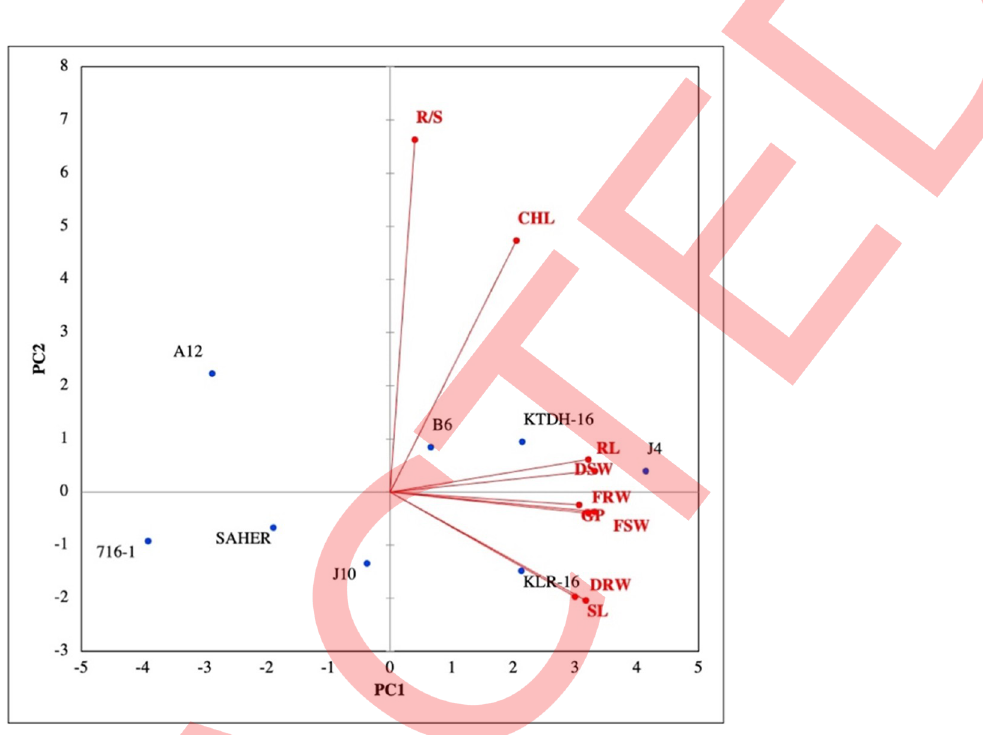
Fig 1. Biplot of the first two principal components of principal component analysis executed on seed germination and growth traits of wheat genotypes included in the study. Here, GP = seed germination percentage, RL = root length, SL = shoot length, RFW = root fresh weight, RDW = root dry weight, SFW = shoot fresh weight, SDW = shoot dry weight, R/S = root:shoot ratio, Chl = chlorophyll index.